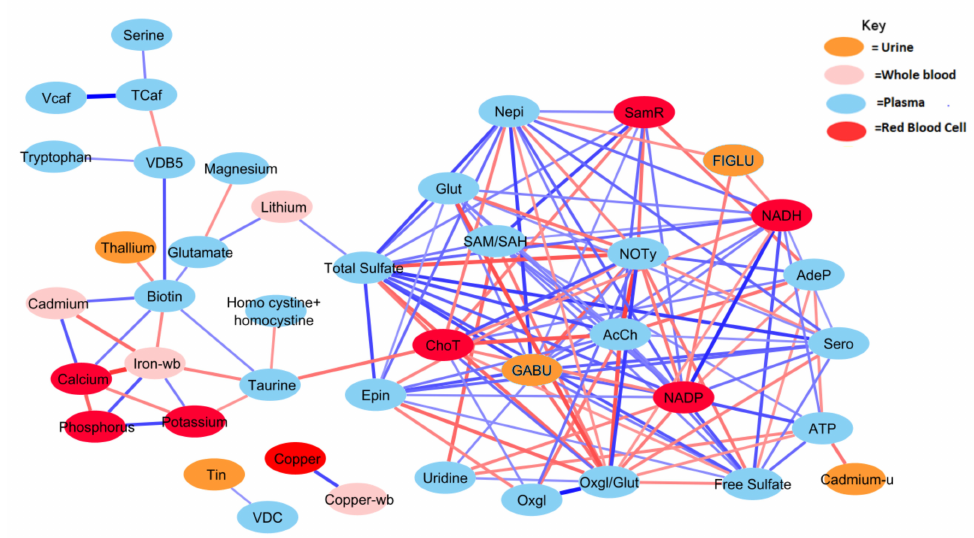
Figure 3. Correlation network between significant biochemical and xenobiotic compounds in the TD cohort (strength of the correlation is visualized by the line thickness, positive correlations are in blue and negative correlations are in red). In order for a relationship to be deemed significant, the correlation coefficient had to be greater than 0.35, FDR less than 0.10, and the p -value less than 0.05. In total, 378 significant correlations were observed that met these criteria. NADP and total sulfate had the greatest number of relationships, with 19 significant relationships. Only those relationships with r > 0.40 are presented (see Table A1 for